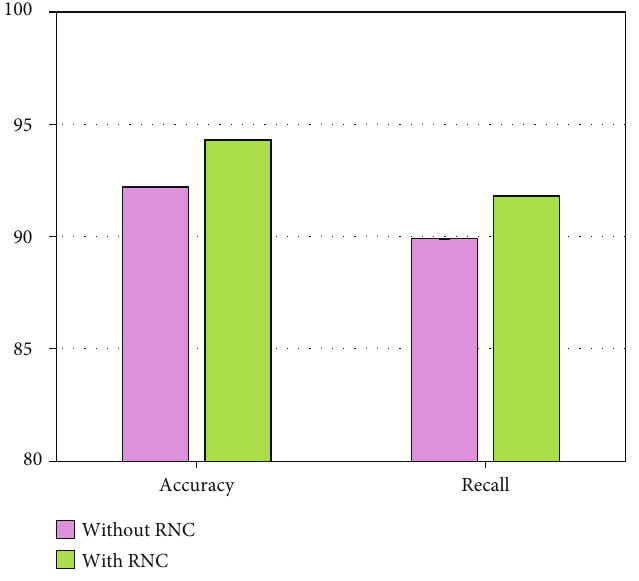
Figure 4: Evaluation on RNC